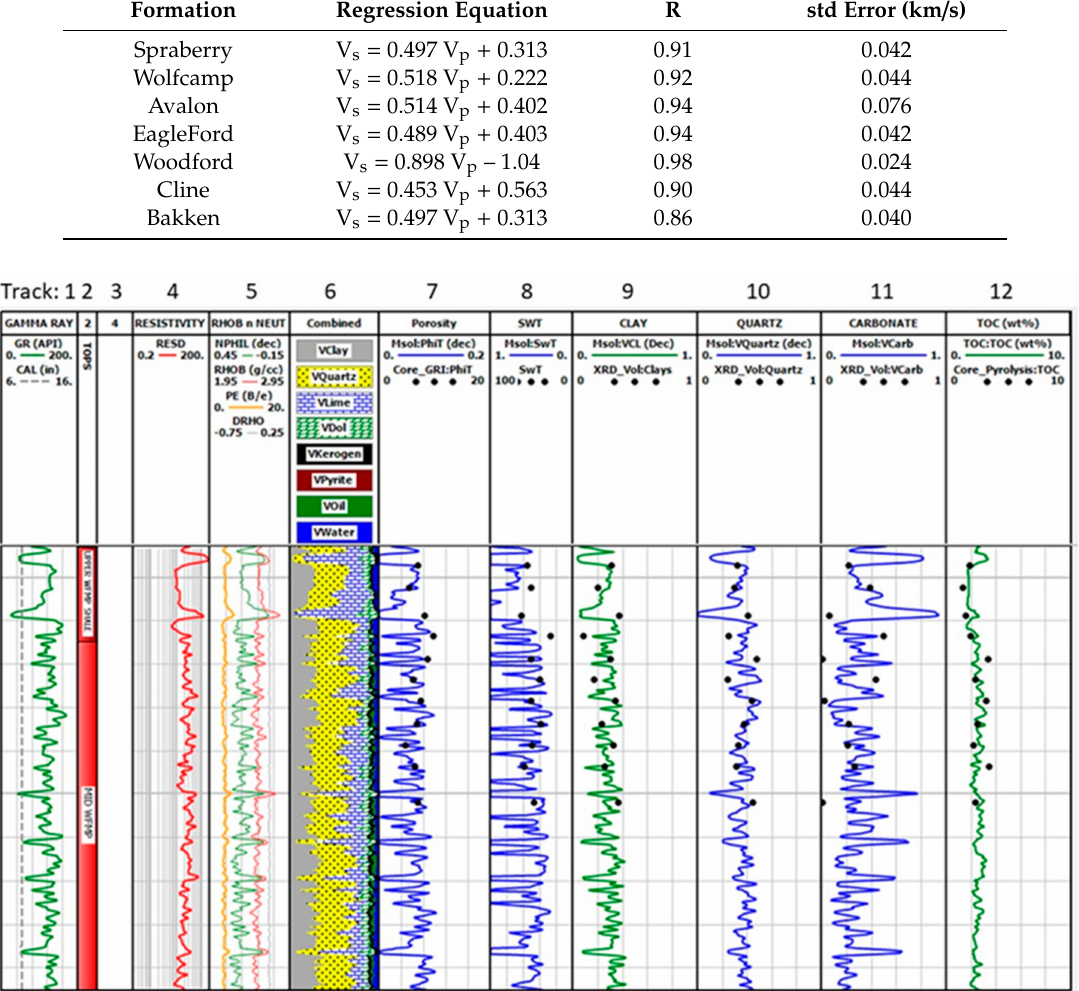
Figure 3. Well log volumetric analysis in the Wolfcamp Formation compared to core X-ray di ff raction, fluid volume, and pyrolysis results showing good average agreement in prediction of porosity, water saturation, clay volume, and TOC weight%. The log analysis procedure is described in (9). The carbonate volume fraction log versus core comparison is misleading due to di ff erences in vertical resolution between the core and well logs, however, the directions of the changes are consistent between logs and core. The vertical depth interval displayed is 200 feet (61 m). Track numbers are from left to right. Track 1: Gamma-ray (GR—solid green curve)) in API units and Caliper (CAL—dashed gray curve) in inches. Track 2: Formation name di ff erentiating Upper Wolfcamp Shale (Upper WFMP Shale) and Middle Wolfcamp Shale (Mid WFMP). Track 3: Blank track. Track 4: Deep resistivity (RILD) in ohm-m. Track 5: Neutron porosity in decimal limestone units (NPHIL—green curve), formation bulk density in gm / cc (RHOB—red curve), and photoelectric e ff ect on barns / e (PE—orange curve). Track 6: Volumetric well-log analysis in fractional decimal units. Volume clay (VClay) in gray, volume of quartz (VQuartz) is dotted yellow, volume of calcite (VLime) is blue bricked, volume of dolomite (VDol) is green